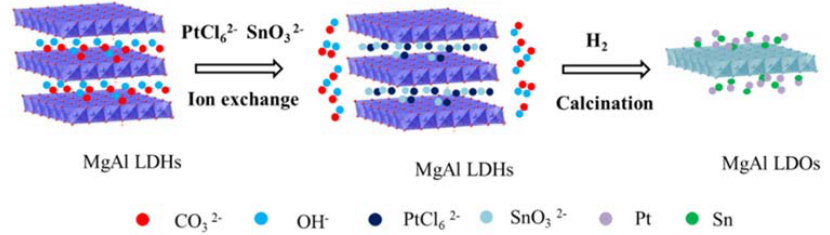
Figure 3. Schematic illustration of loading Pt and Sn precursors onto Mg(Al)O LDHs through the anion exchange method.